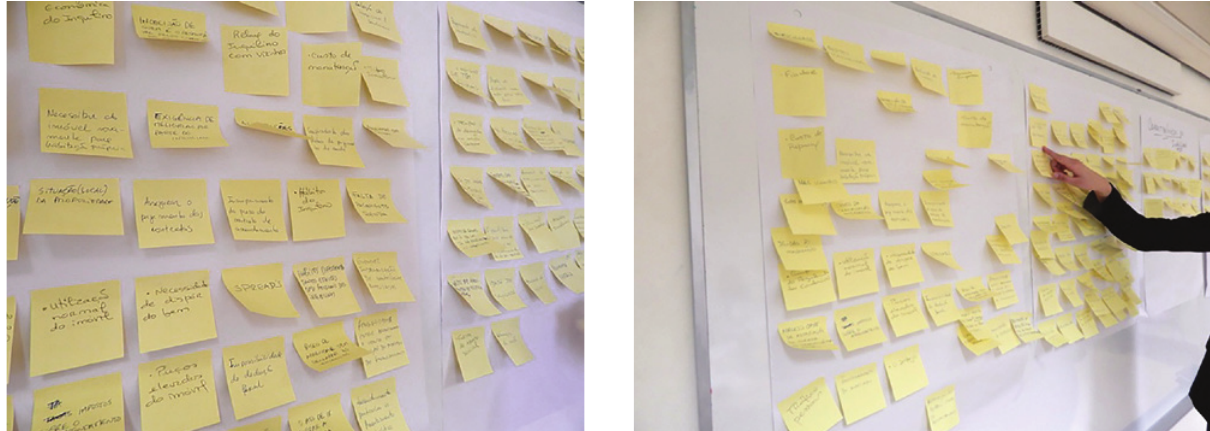
Figure 2. Application of the post-its technique